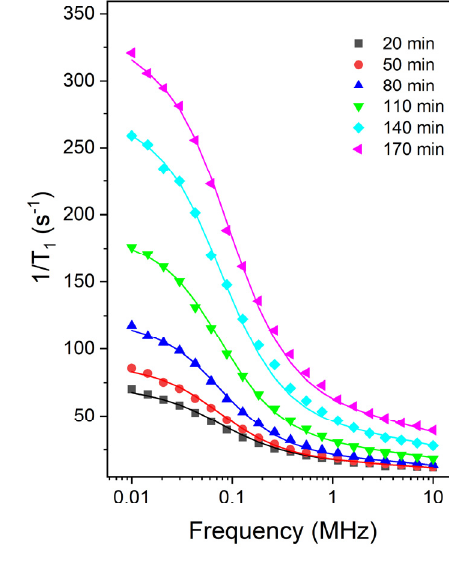
Figure 2. ( a ) Capillary peak area versus hydration time for the two cement pastes. ( b ) Relaxation rates corresponding to the maximum of the capillary versus hydration time.